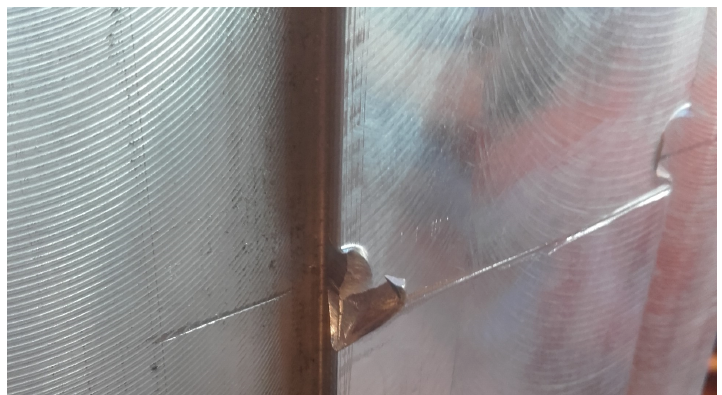
Figure 16. Picture of a damaged wedge on the pipe, the result of a failed mounting attempt that happened early on during the development of the system, where a poorly aligned pole-shoe was being forced onto the pipe at too high